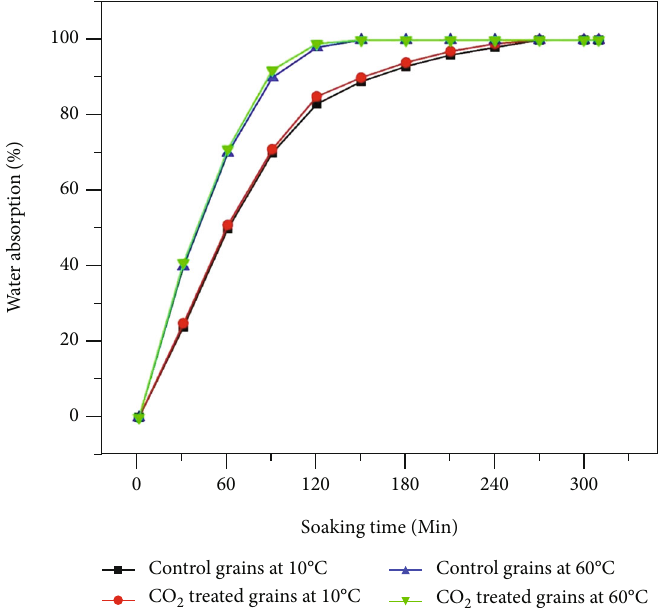
treatment and (b) after CO 2